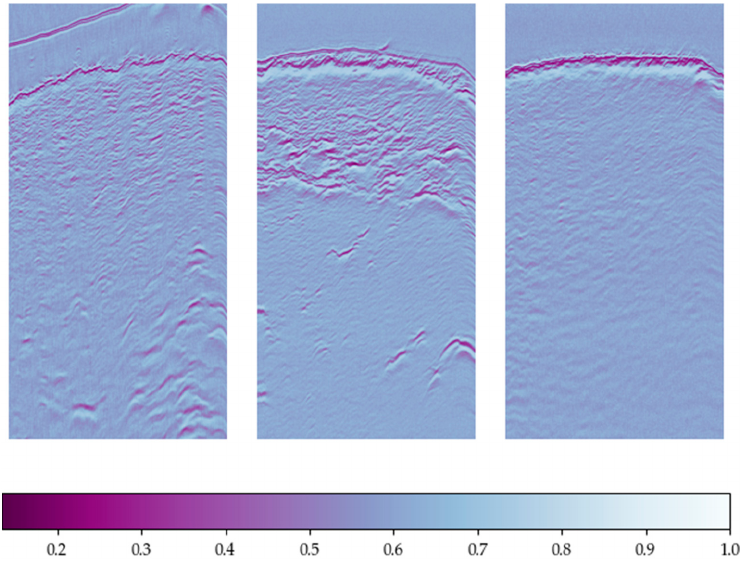
Figure 7. Sample scans acquired with the EPISCAN system. From left to right: cheek sample from a 28-year-old man; forearm sample from a 59-year-old woman; and lips sample from a 41-year-old woman. The colormap shows relative units (each image has been normalized between 0 and 1). The vertical direction corresponds to the skin depth with the outermost layer at the top of each image.